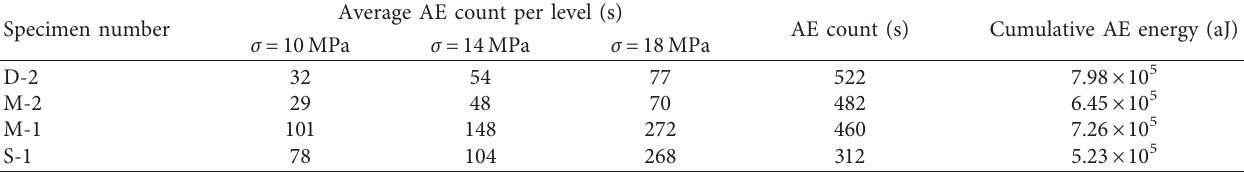
Shock and Table 2: Characteristic AE parameters of the creep disturbance of the mudstone specimens with different moisture contents. Specimen number